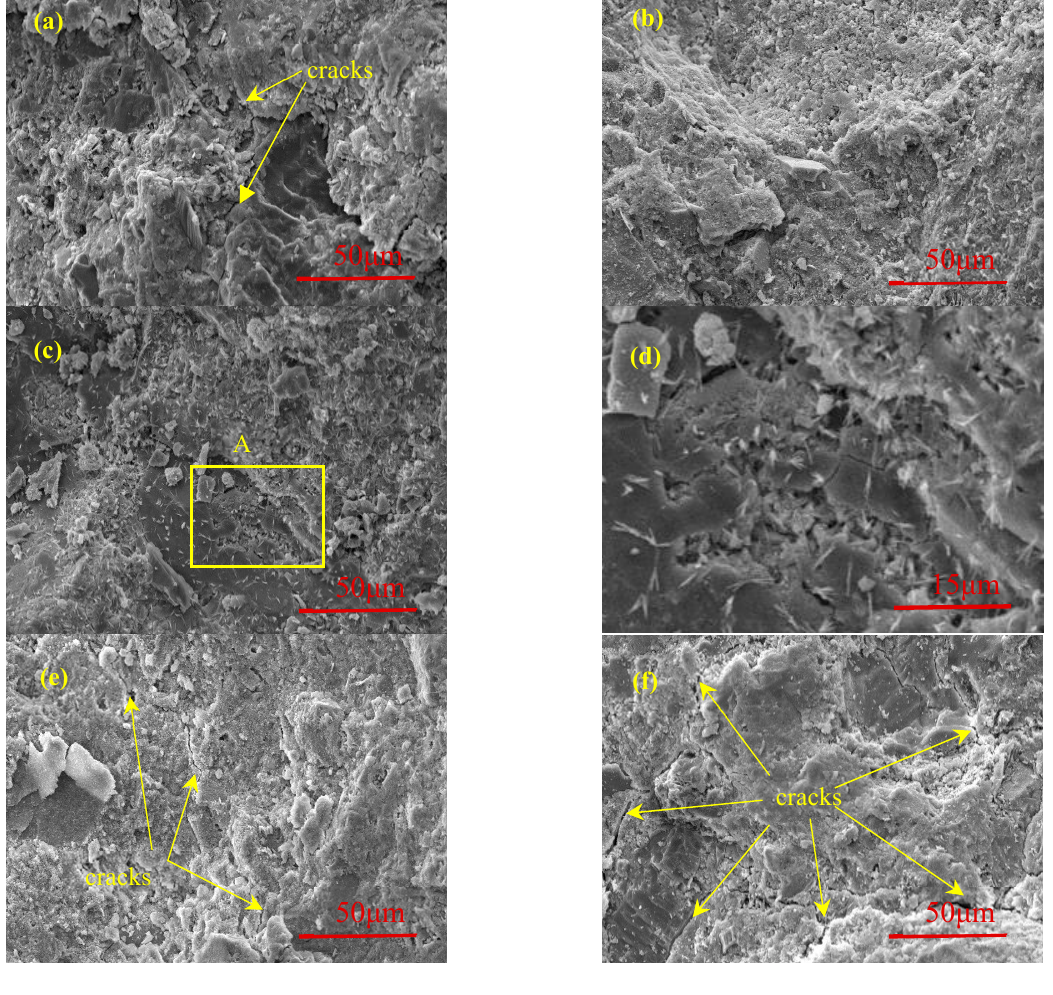
Figure 4. Cracks development of C30 specimen at different sulfuration ages: ( a ) 0 days; ( b ) 2 days; ( c ) 5 days; ( d ) A in ( c ); ( e ) 10 days; and ( f ) 20 days.